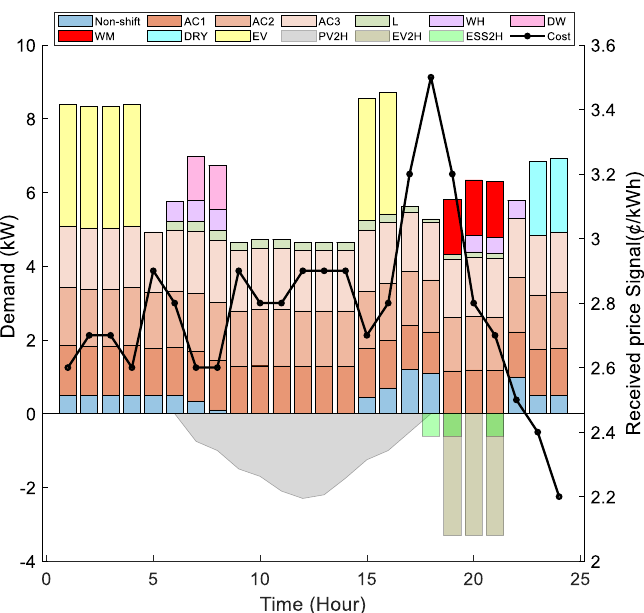
Figure 6. Load profile considering the impact distributed energy resources.